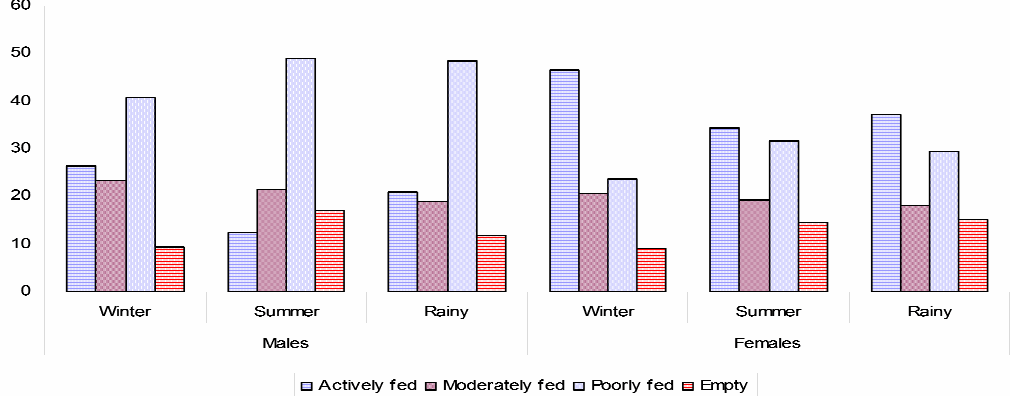
Fig. 13. Feeding intensity with reference to seasons in males and females of S.